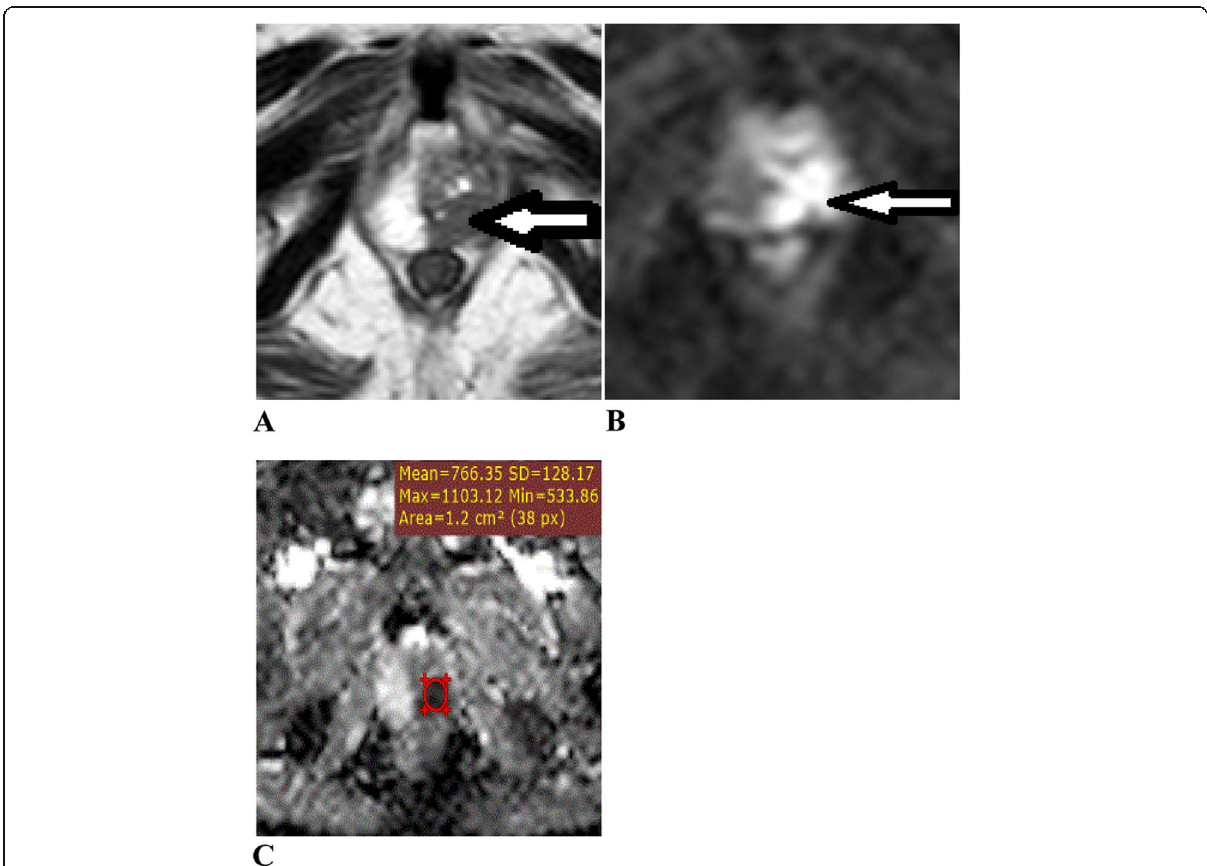
Fig. 6 A 73-year-old male patient with total PSA 169 with concordant interpretation in terms of PIRADSv2 DWI score. a Axial T2 showing left peripheral zone low signal intensity lesion 1.7 cm with wide base abutting the capsule. b DWI (at b value 800) showing marked bright signal intensity of the lesion. c ADC map image showing marked low signal intensity of the lesion with mean ADC value 0.766. The DWI score was 5 for readers 1 and 2. The ADC ratio between benign prostatic tissues was 1.66. Histopathology was adenocarcinoma GS 4 + 4 = 8; tumor volume = 1.6 cm 3 ;